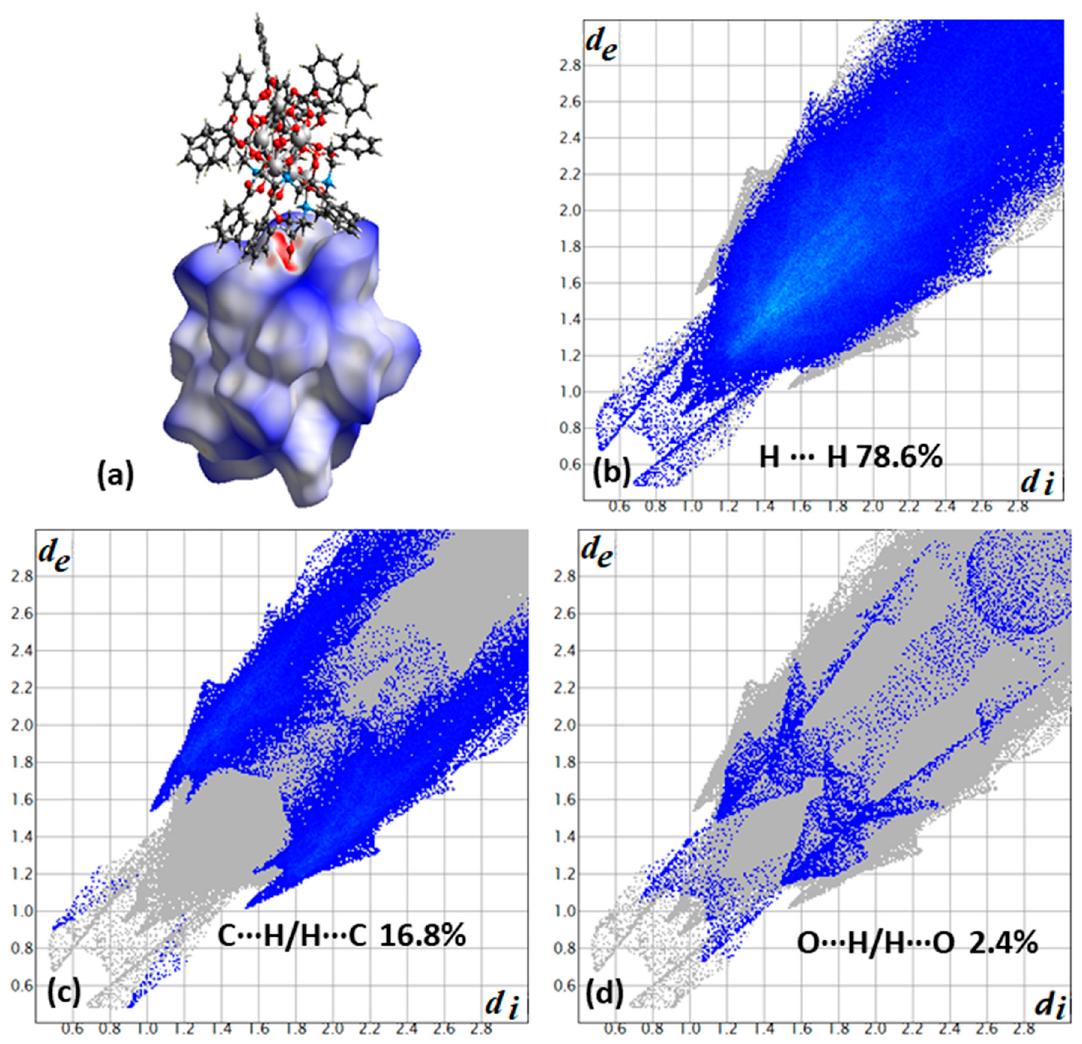
Figure 3. ( a ) A dimer of complexes with one molecule to be surrounded with a d norm decorated HS and the other in a ball and stick presentation for compound 3 . Contribution of each type of interactions ( b ) H ∙∙∙ H, ( c ) C ∙∙∙ H/H ∙∙∙ C, and ( d ) O ∙∙∙ H/H ∙∙∙ O derived from the fingerprint plot of compound 3. The outline of the full fingerprint contribution is shown in gray.